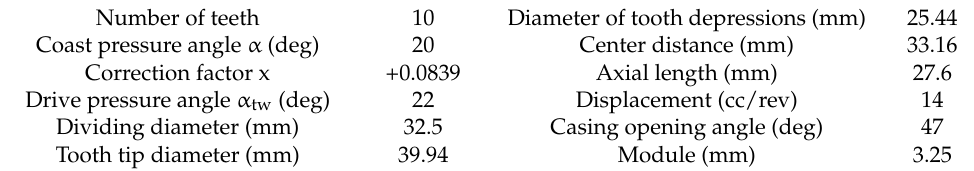
Table 1. The gear pump specifications taken as reference in this approach.